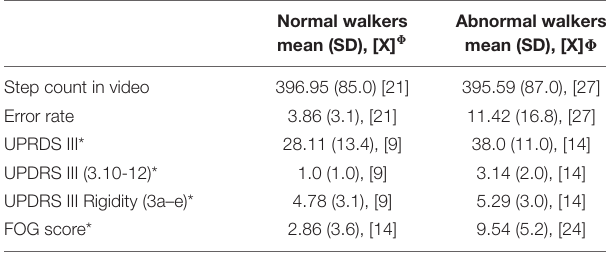
TABLE 2 | Comparison of normal and abnormal walkers in cohort 1.